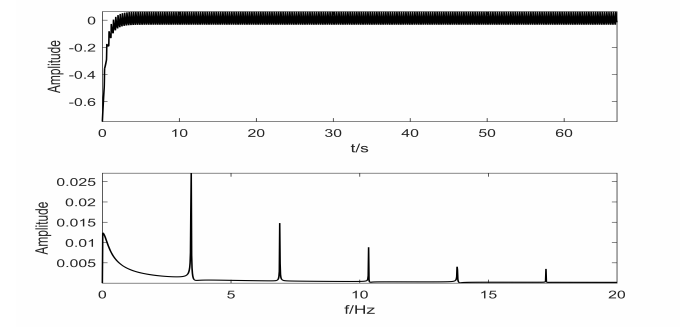
Figure 13. Actuator normal and actuator spindle bending failure data spectrum.